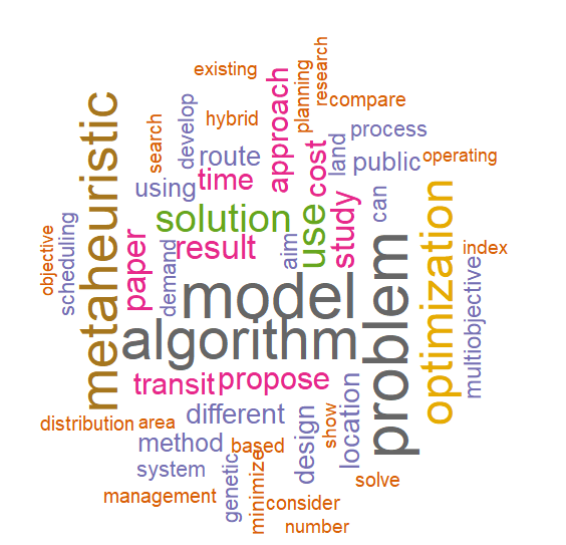
Figure 5. Wordcloud from the abstracts of works on public sector and public-private